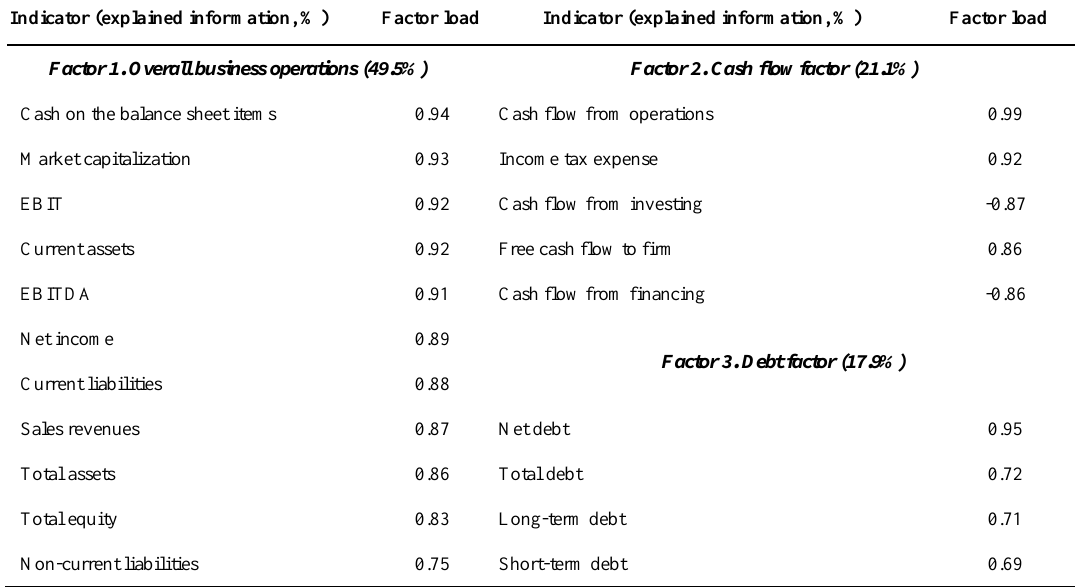
Table 3. Factor analysis results of 510 Nordic countries stock market listed companies’ absolute value indicators in 2004-2018. Indicator (explained information, %) Factor load Indicator (explained information, %) Factor 1. Overall business operations